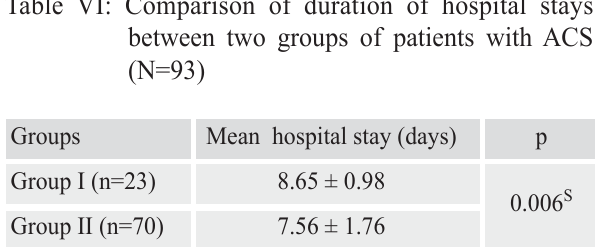
Table VI: Comparison of duration of hospital